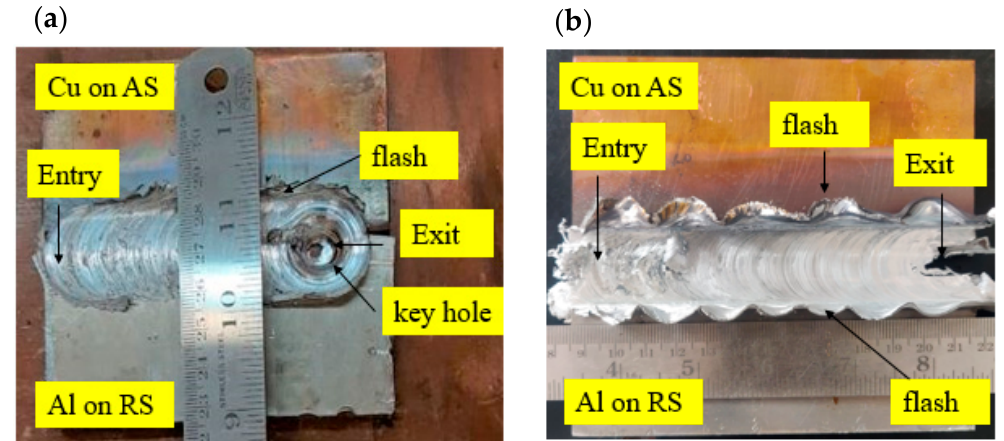
Figure 3. The top surface images of the Al/Cu joints welded with ( a ) CFSW, ( b ) BTFSW.